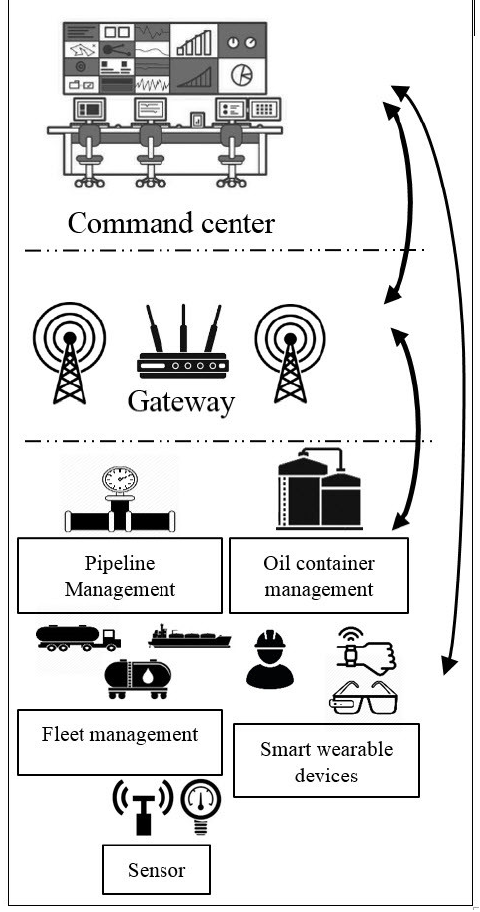
Figure 1. IoT-based oil production industry network.